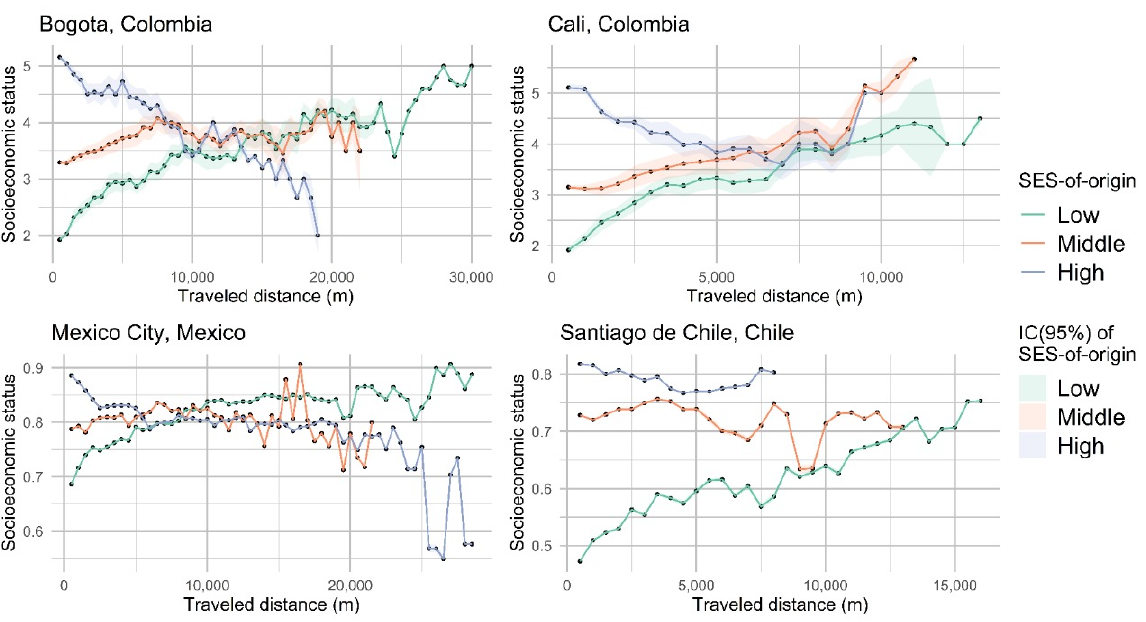
Figure 3. Maximum SES percentile difference reached by participants using the Ciclov í a route, compared with their average SES-of-origin, as well as distance participants traveled to achieve that difference; SES: socioeconomic